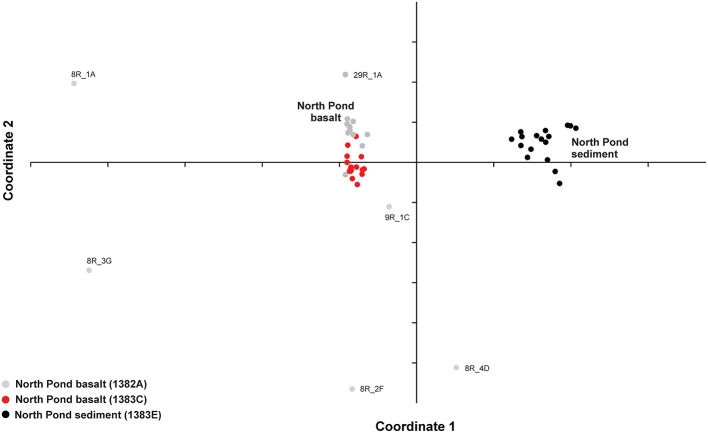
Comparison between community structures. Relative abundance of OTUs in each sample was used to compare the variation between the basalt-hosted communities and the sediment-hosted communities by means of non-metric multidimensional scaling (NMDS). Samples are color coded gray: Hole 1382A, red: 1383C, black: North Pond sediment from Hole 1383E.